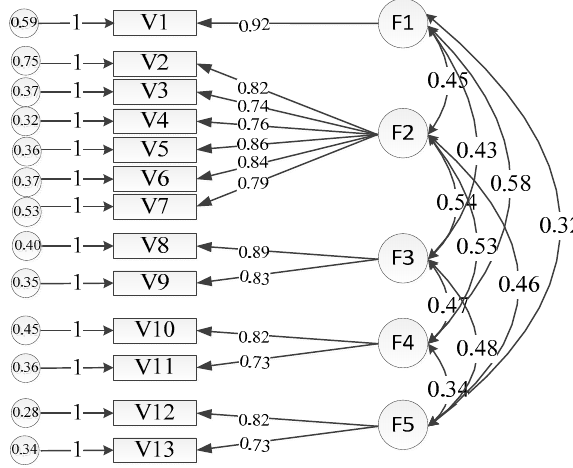
Figure 2. Estimations of the standardized path coefficient of the confirmatory factor model.